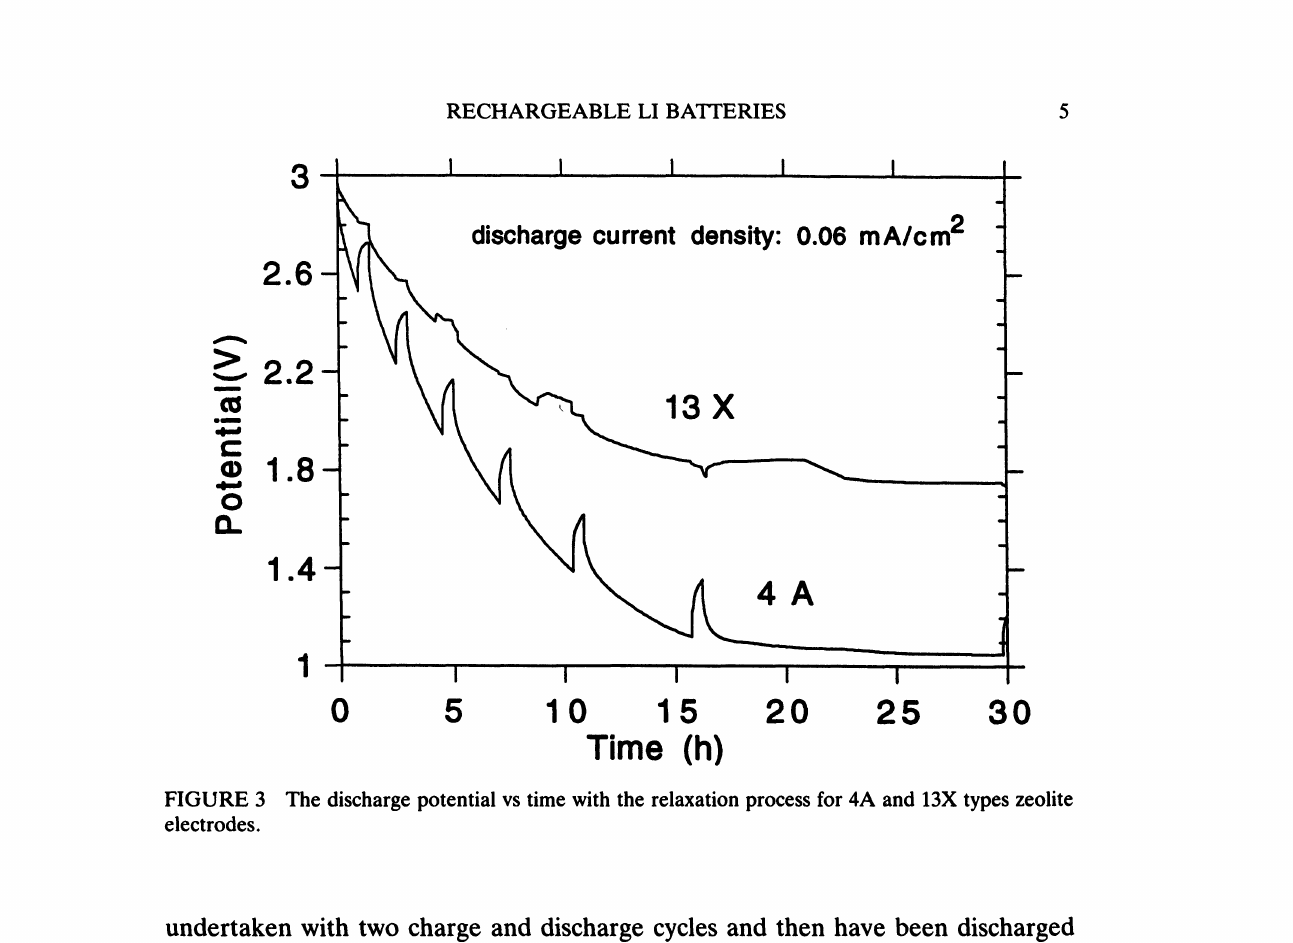
FIGURE 3 The discharge potential vs time with the relaxation process for 4A and 13X types zeolite electrodes.